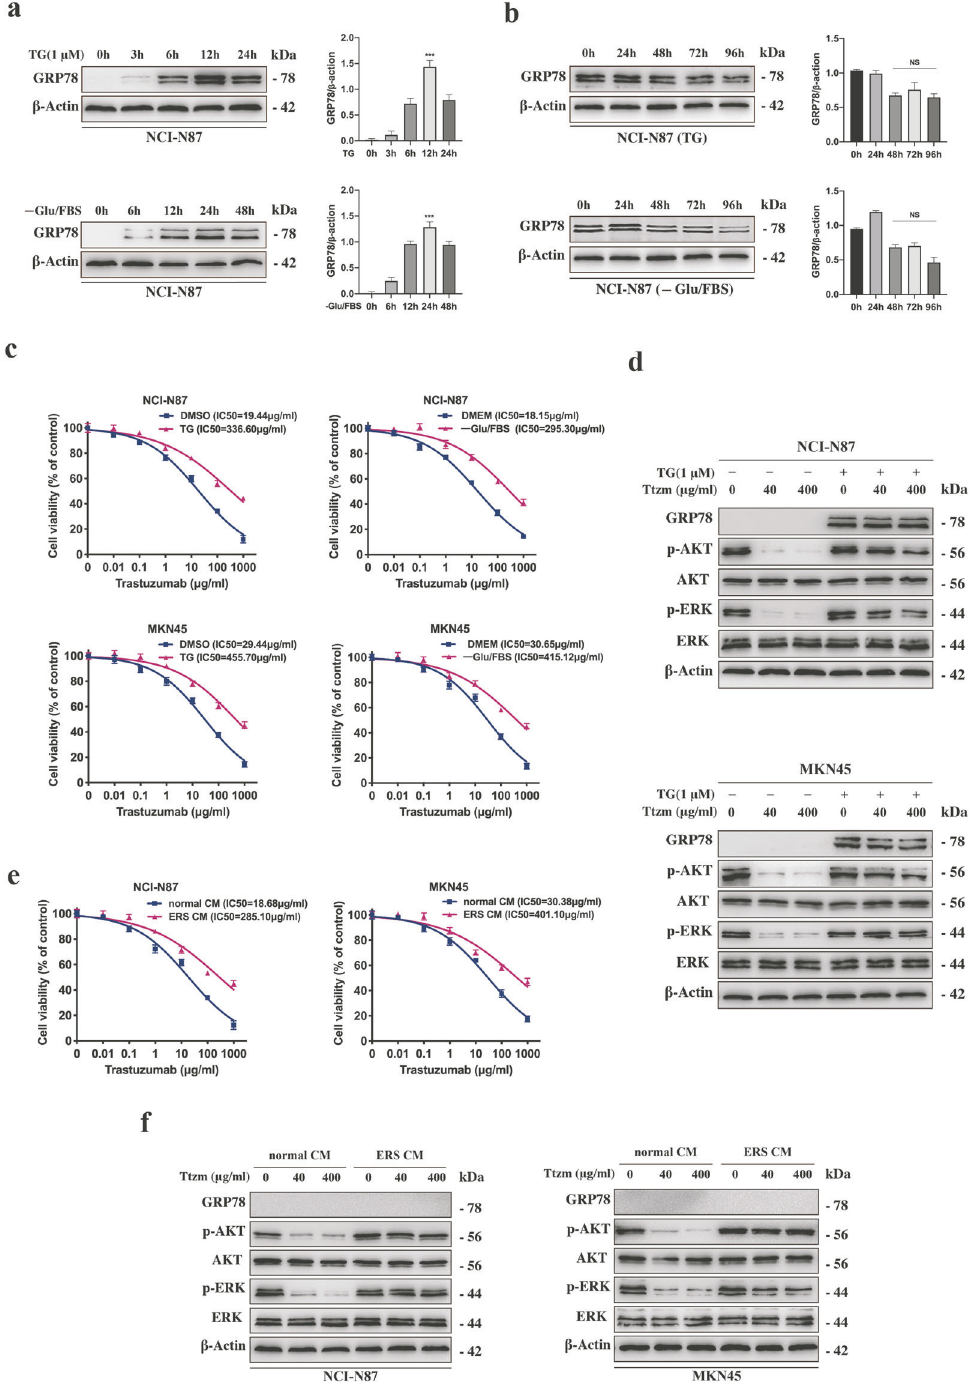
Fig. 1 Activation of ER stress in HER2-positive GC cells was related to trastuzumab resistance. a Representative western blot and quanti fi cation for GRP78 in NCI-N87 cells after treated with 1 μ M TG for 0, 3, 6, 12 and 24 h and -Glu/FBS for 0, 6, 12, 24 and 48 h, respectively. b Representative western blot and quanti fi cation for GRP78 in NCI-N87 cells after treated with 1 μ M TG for 12 h or -Glu/FBS for 24 h following culture in normal CM for 0, 24, 48, 72, and 96 h, respectively. c CCK8 assay after NCI-N87 and MKN45 cells were treated by 1 μ M TG for 12 h or -Glu/FBS for 24 h before trastuzumab treatment for 72 h ( n = 3). d Western blot analysis for protein expression in NCI-N87 and MKN45 cells after treatment with or without 1 μ M TG for 12 h followed by 40 or 400 μ g/ml trastuzumab treatment for 72 h. e CCK8 assay after NCI-N87 and MKN45 cells were treated by speci fi c medium for 24 h before trastuzumab treatment for 72 h ( n = 3). f Western blot analysis for protein expression in NCI-N87 and MKN45 cells after treatment with speci fi c medium for 24 h after 40 or 400 μ g/ml trastuzumab treatment for 72 h. Statistical analysis was performed by Student ’ s t -test, error bars indicate SD (*** p < 0.001, NS no signi fi